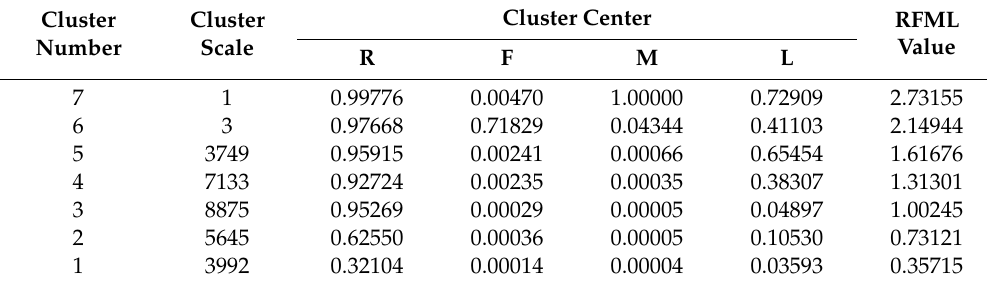
Table 2. Results of clustering.